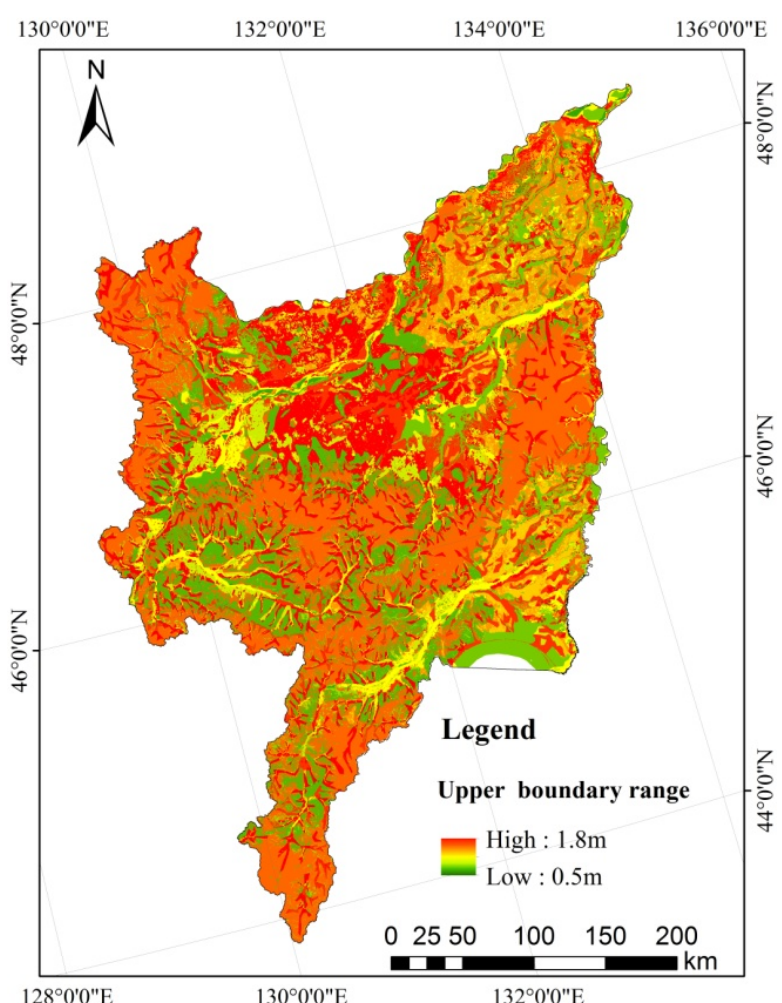
Figure 12. Spatial distribution of the upper boundary of ecologically ideal shallow groundwater depth (EISGD) in the Sanjiang Plain, northeast China. Five vegetation types in the region were used for defining an upper EISGD boundary ranging from 0.5 and 2.8 m. The rice paddies showed a range between 1.1 and 12.2 m, with a mean value of 6.7 m. The meadows had a wider range of EISGD from 0.8 to 13.9 m, with an average of 7.3 m. For the woodland areas, we identified an EISGD range between 2.4 and 14.3 m, with a mean of 8.3 m. For the crop farmland, we found an EISGD range between 0.8 and 9.3 m, with a mean of 5.1 m. For the wetlands, we identified an EISGD range between 0.5 and 13.4 m, with an average of 6.9 m (Figure 13). Spatially, the deepest and shallowest lower boundaries of EISGD occurred in the northeast and southeast areas of the Sanjiang Plain, respectively (Table 2 and Figure 11). The deepest and shallowest upper boundaries of EISGD were located in the north and southeast of the Sanjiang Plain, respectively (Table 3, Table 4 and Figure 12). As for the entire Sanjiang Plain, the largest (13.9 m) and smallest (6.4 m) range of EISGD mainly occurred in the northeast and central Sanjiang Plain, respectively (Figure 13), indicating a potentially higher pumping capacity of the area when compared with other areas on the Sanjiang